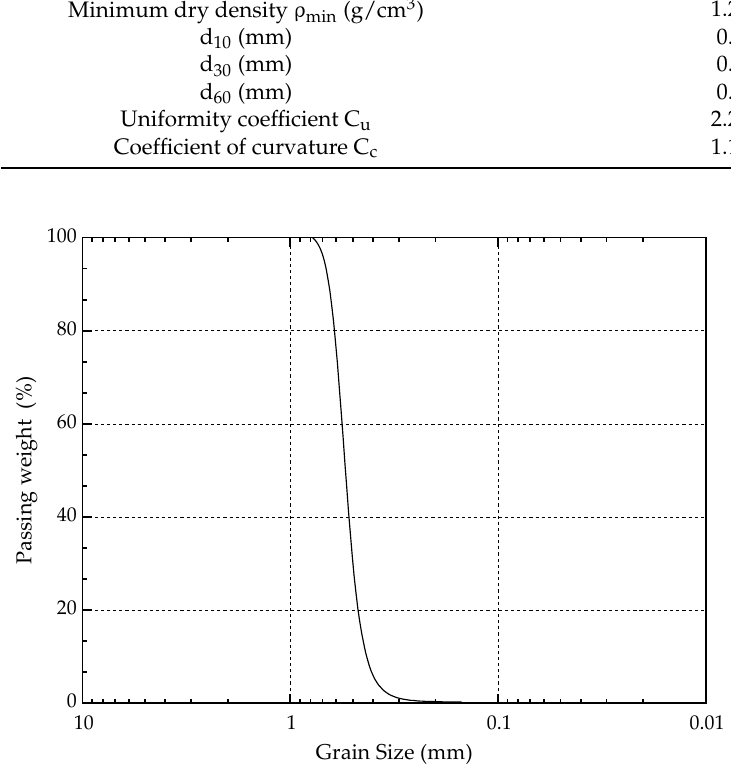
Figure 1. Grain size distribution of the calcareous sand.